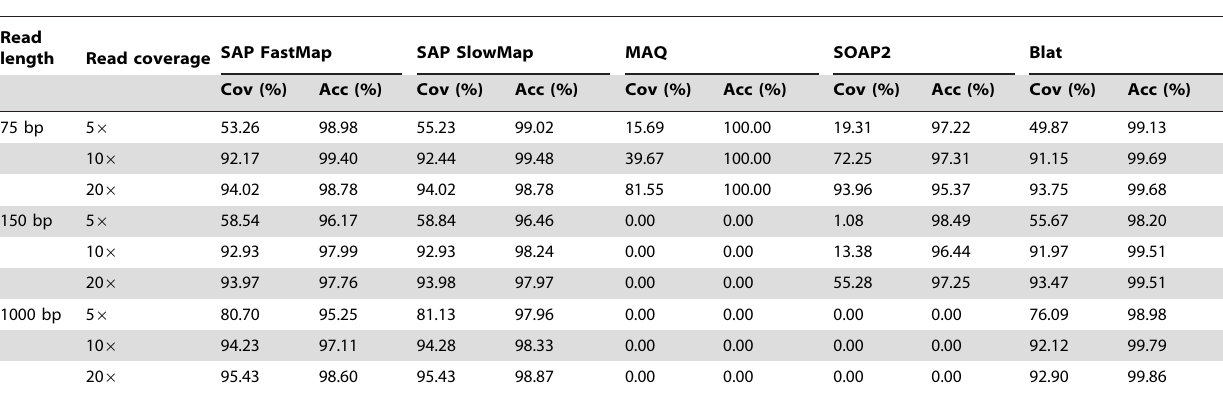
Table 3. Performance of different algorithms on SNPs detection in simulated data.